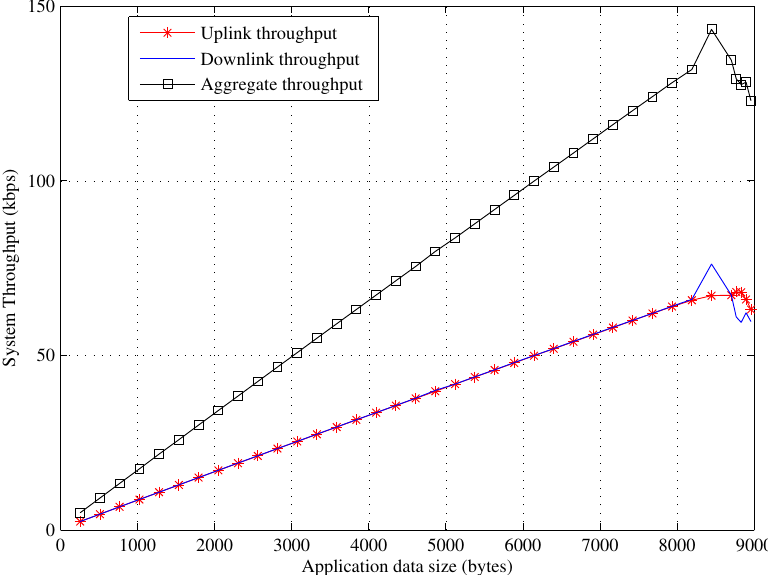
Figure 9. System throughput as a function of application data